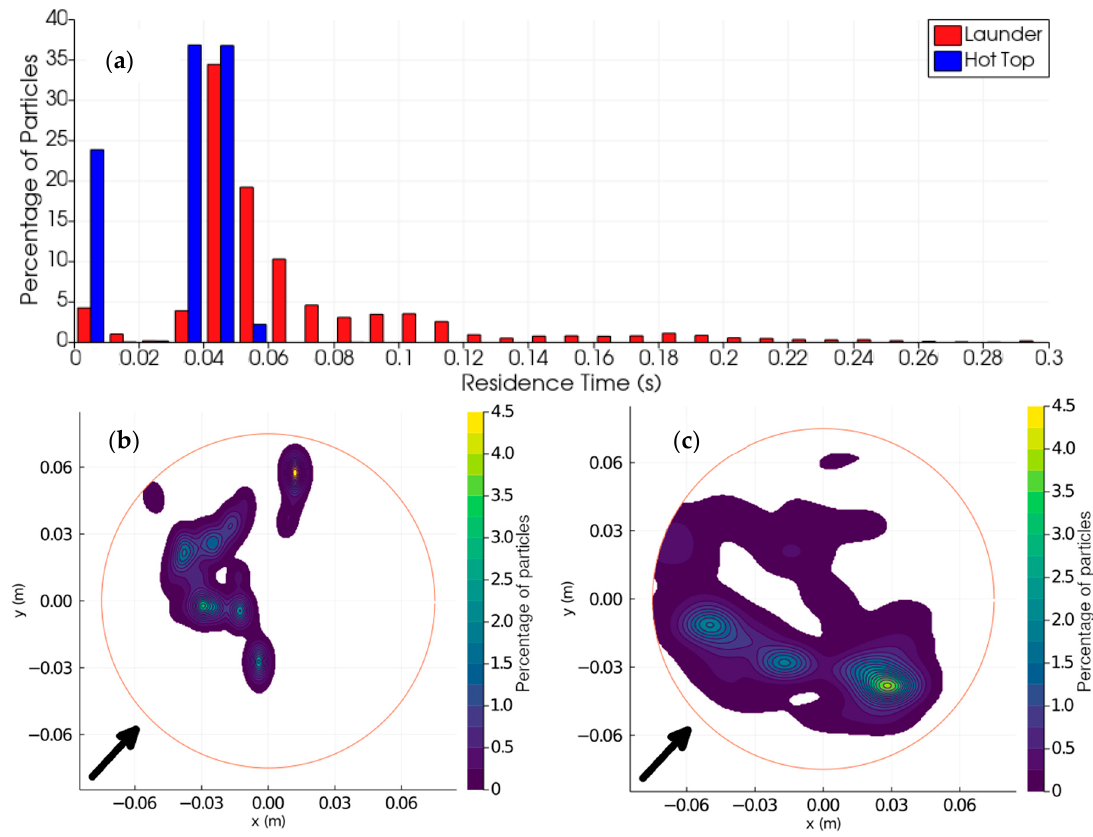
Figure 9. Particle residence time ( a ), and computed refining particle distributions in the billet through processing in the hot-top ( b ) and in the launder ( c ). Arrow on the bottom left indicates the inlet flow direction.